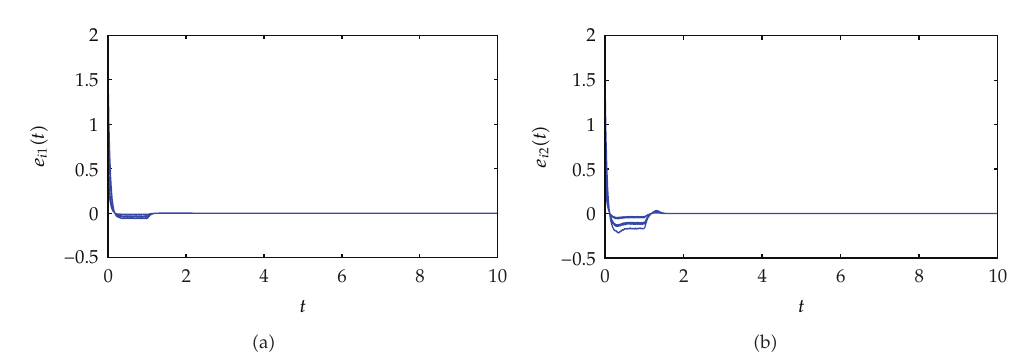
Figure 4: The time evolution of e i 1 and e i 2 (cid:3) i (cid:8) 1 , 2 ,..., 5 (cid:4) in system (cid:3) 4.3 (cid:4) under pinning